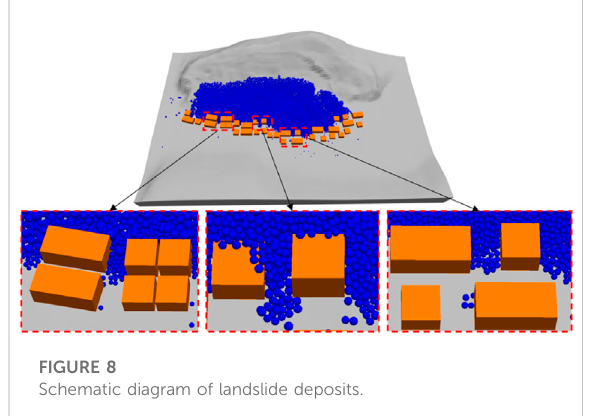
FIGURE 8 Schematic diagram of landslide deposits.